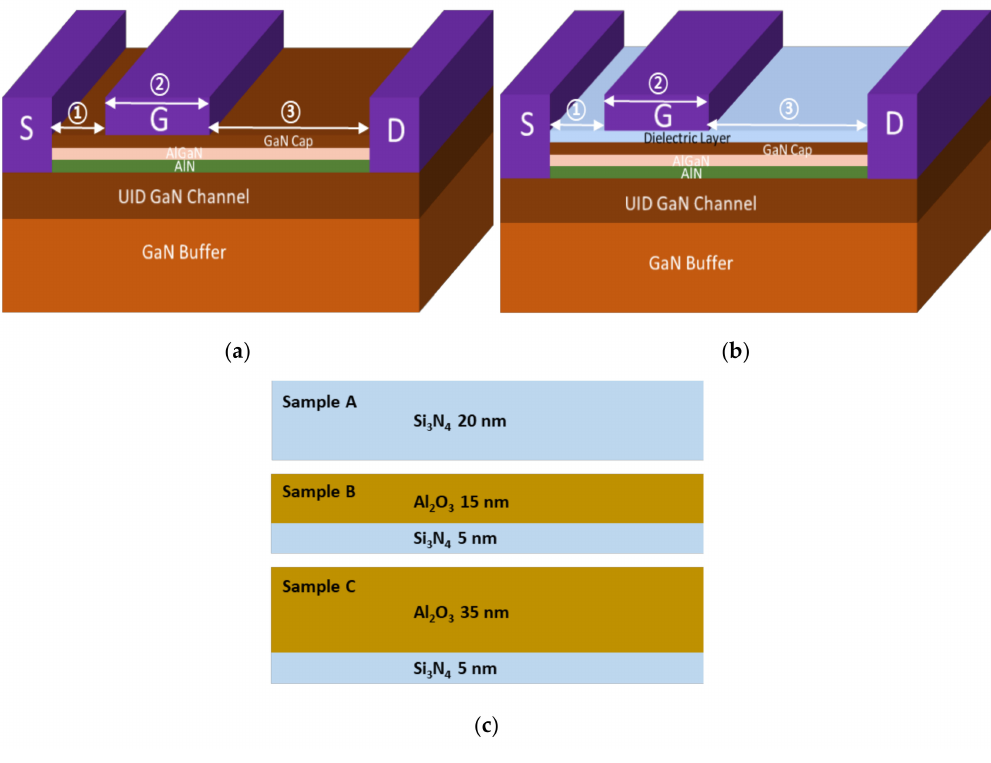
Figure 1. Basic AlGaN / GaN-based MIS-HEMT ( a ) without and ( b ) with a dielectric layer, and ( c ) dielectric layer composition and thickness for samples A, B, and